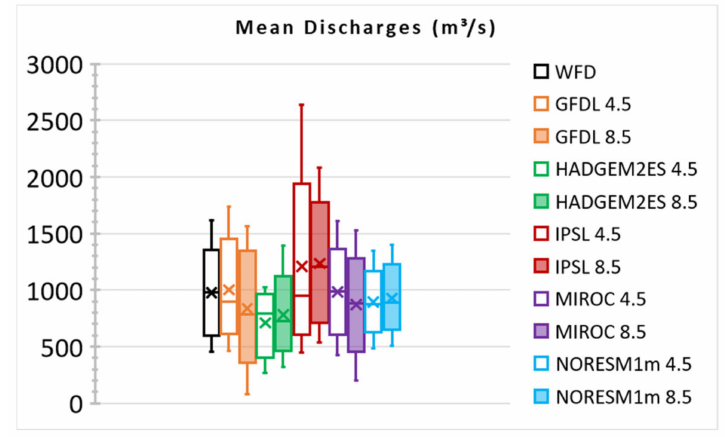
Figure 11. Mean discharges (m 3 /s) for each GCM and both scenarios in the IRB. Table 5. Itacai ú nas River basin flow in the reference period (WFD) and future period (each GCM and mGCMs), and the mean relative difference (MRD) between the GCMs’ mean and WFD. Time Period Data